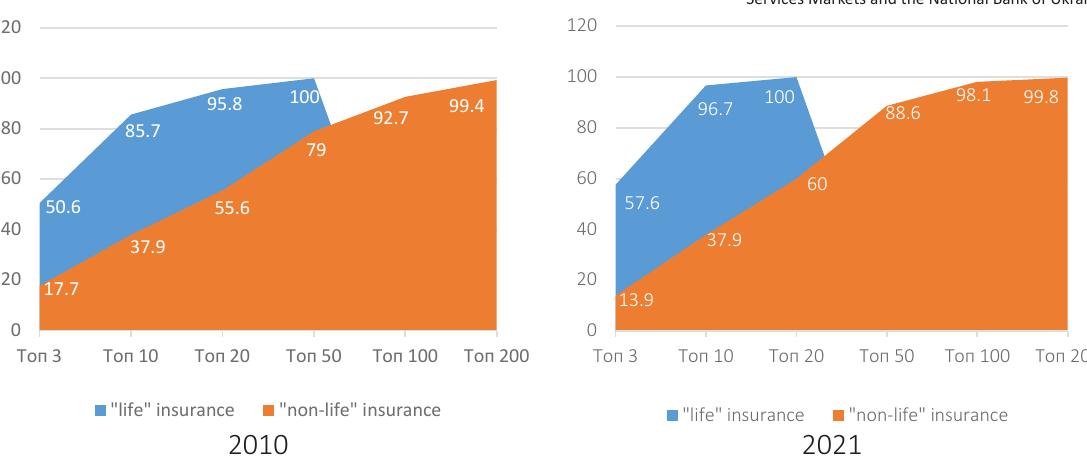
Figure 3. Concentration of the insurance market in 2010 and 2021